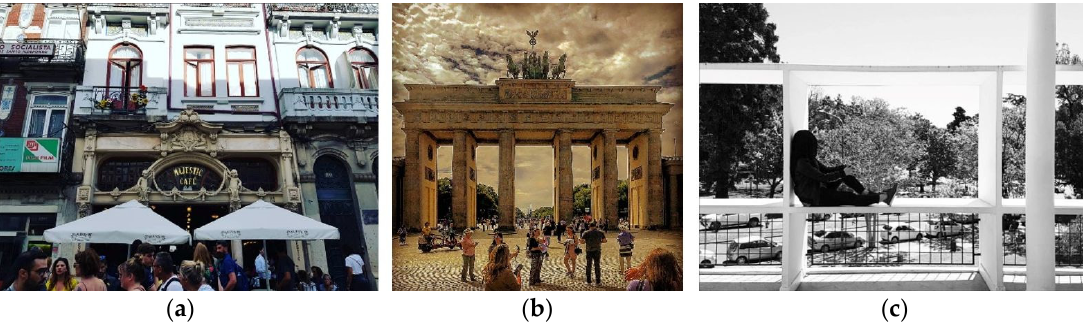
Figure 2. Architectural heritage pictures collected from #patrimonioarquitectonico in Instagram with human dimension: ( a ) font, celinaaida; ( b ) font, pedrodelrealc; ( c ) font, angelacarvajalf.